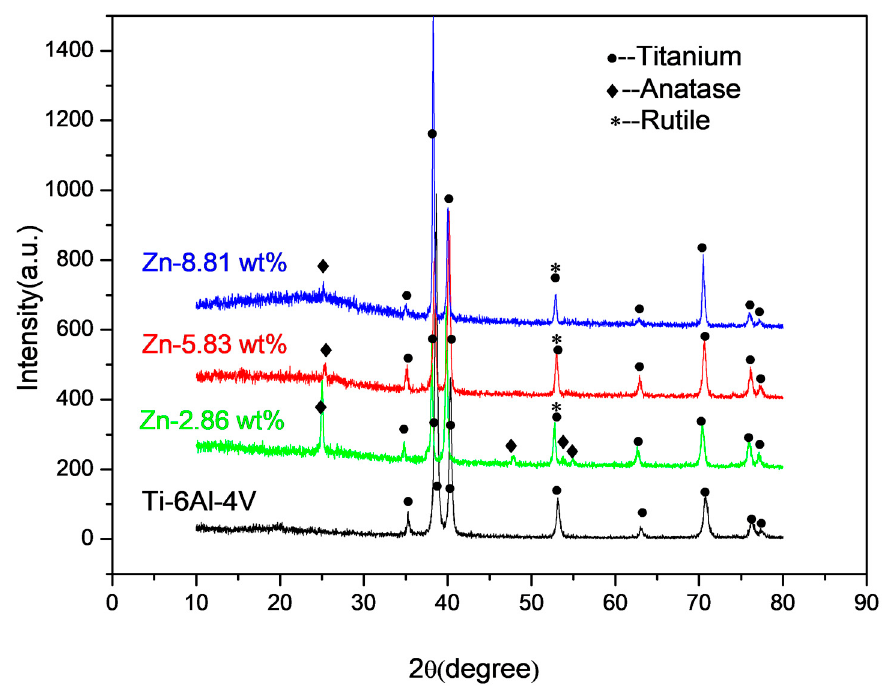
Figure 5. The X-ray diffraction patterns of the untreated Ti-6Al-4V, the MAO coatings containing 2.86 wt %, 5.83 wt % and 8.81 wt % zinc.